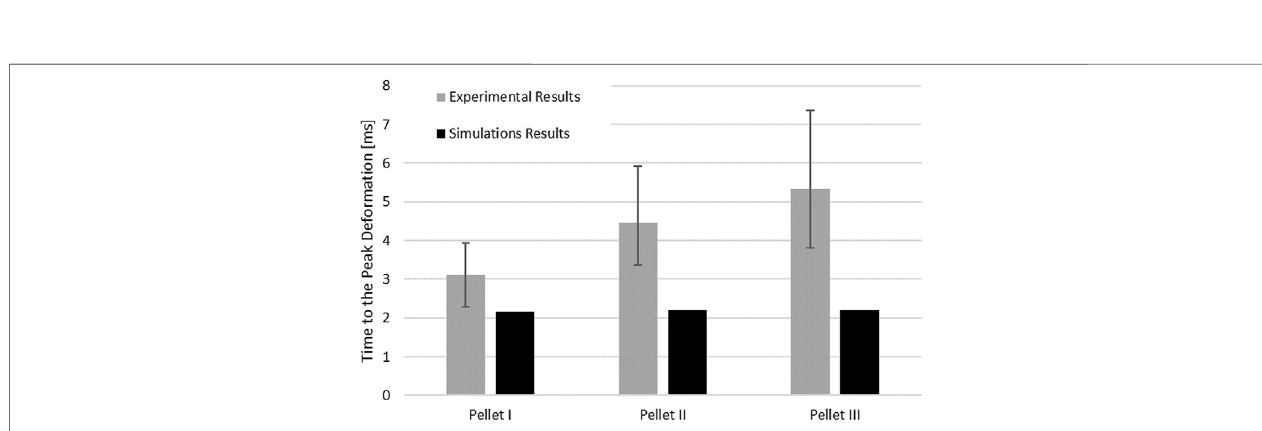
FIGURE 9 | Comparison of the time to the peak deformation for three impacts with experimental data.